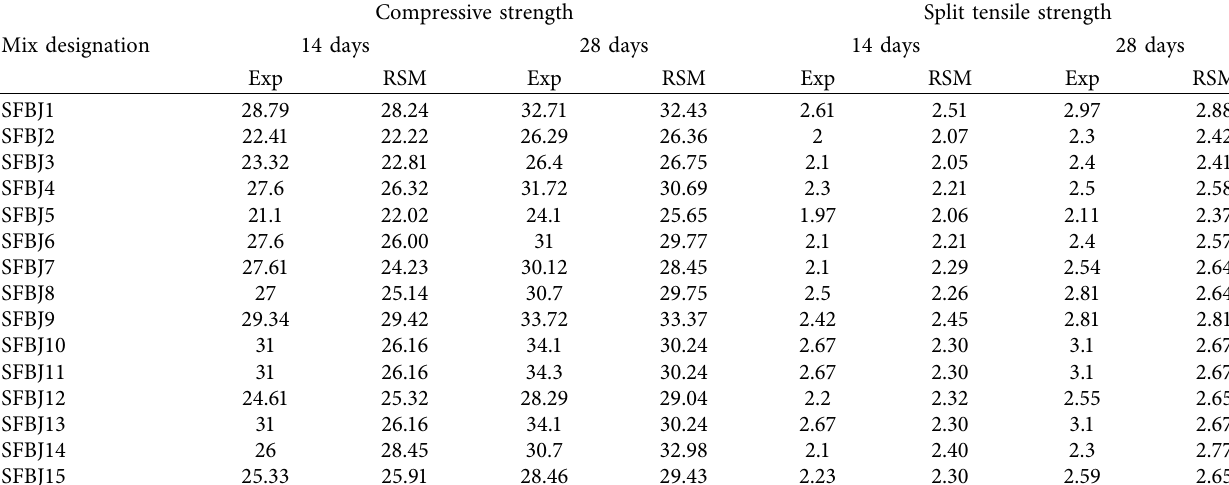
Table 4: Comparison of experimental and predicted